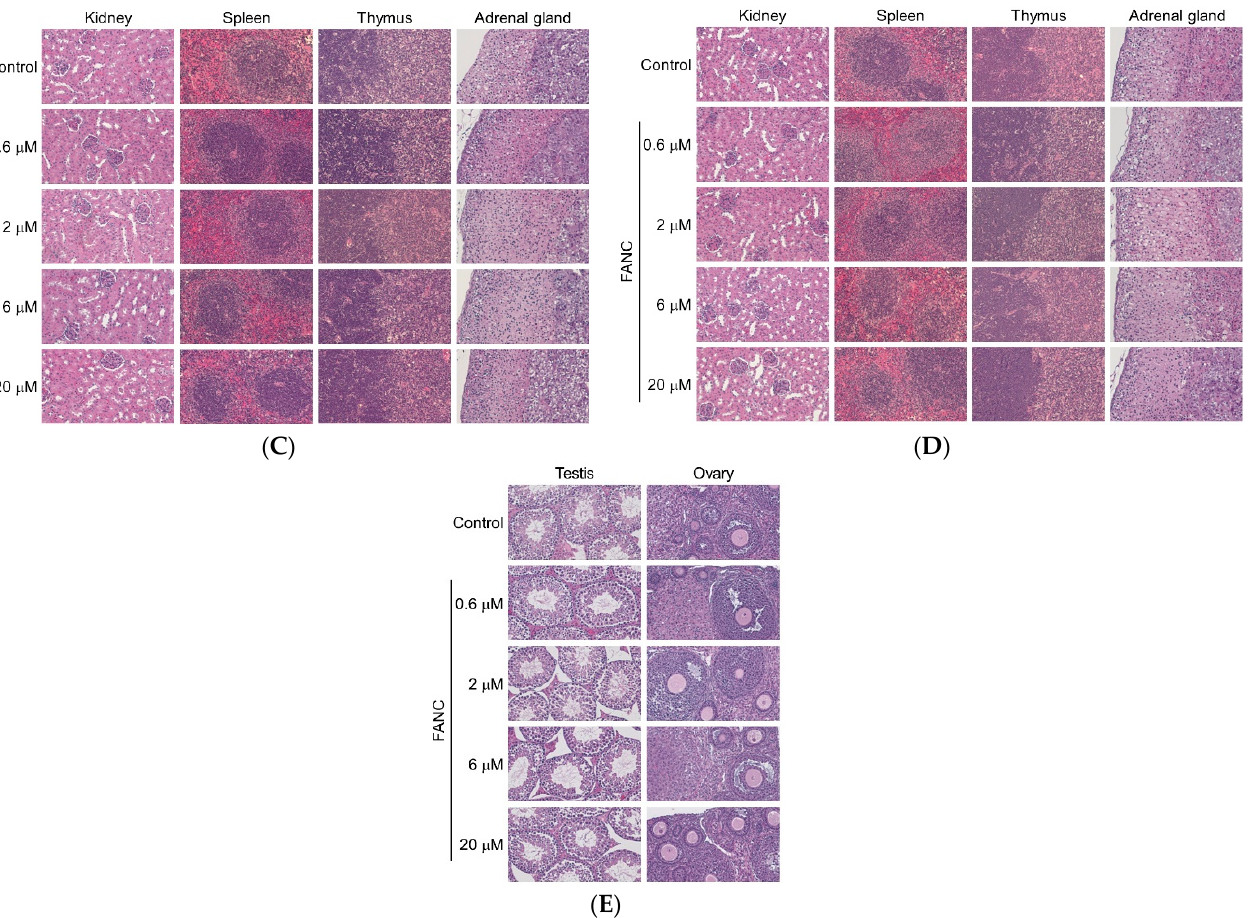
Figure 3. Representative H&E stained histology of tissue from ICR mice after feeding a single dose of FANC. Section of brain, heart, liver, and lung from ( A ) male and ( B ) female mice. Section of kidney, spleen, thymus, and adrenal gland from ( C ) male and ( D ) female mice. ( E ) Section of testis and ovary from mice.